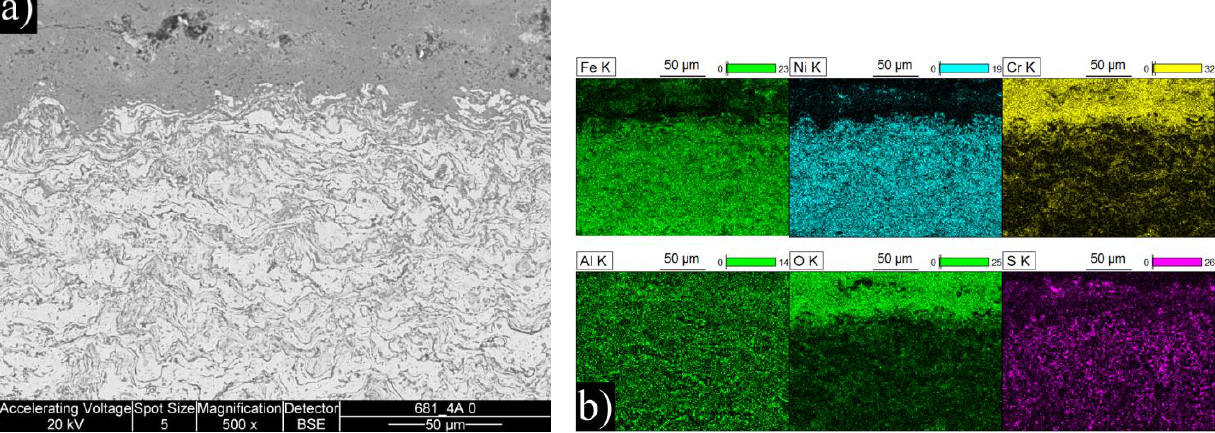
Figure 9. ( a ) SEM image of a cross-section of the HVOF DJ sprayed FeNiCrAl coating